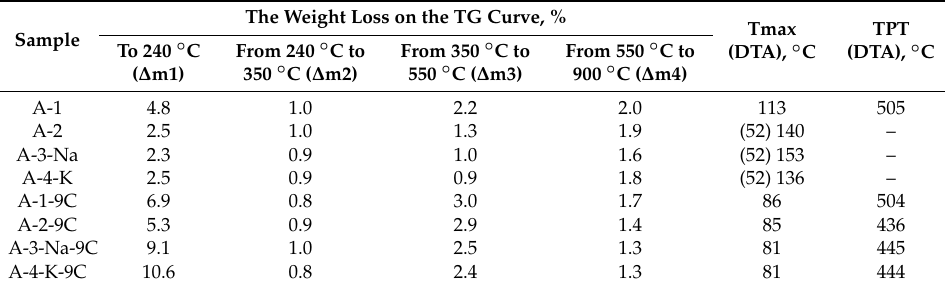
Table 1. DTA and TGA data of the alumina samples.